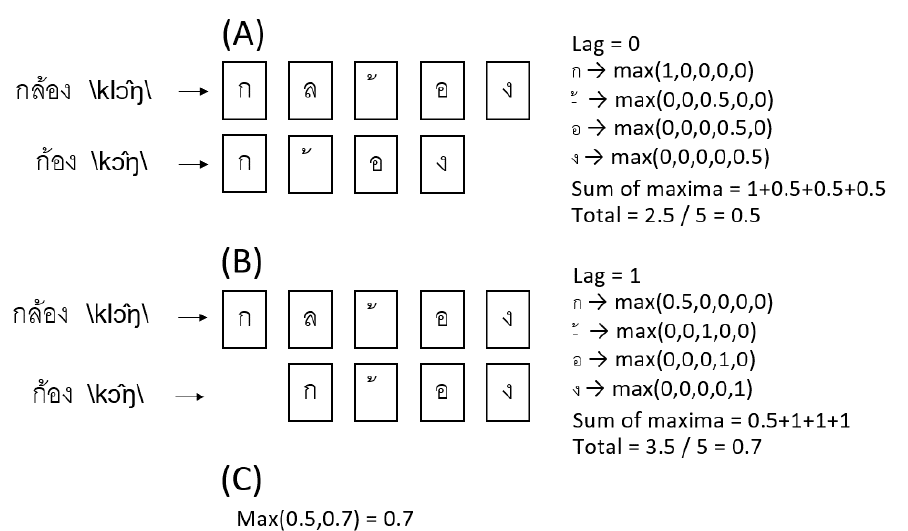
Figure 3. Illustration for orthographic similarity. ( A ) Words are placed at the same index to compare their letters. For calculating the maximum value, each letter in the shorter word is compared with the longest in every index. The quotient is 1/k, where k denotes the overlapped number of words index. The maximum quotients in each letter of the shorter word are summarized and divided by the longer word’s length. ( B ) The shorter word is shifted by one index; repeat the calculation of the maximum value. ( C ) Finding the maximum from the values obtained from every lag.